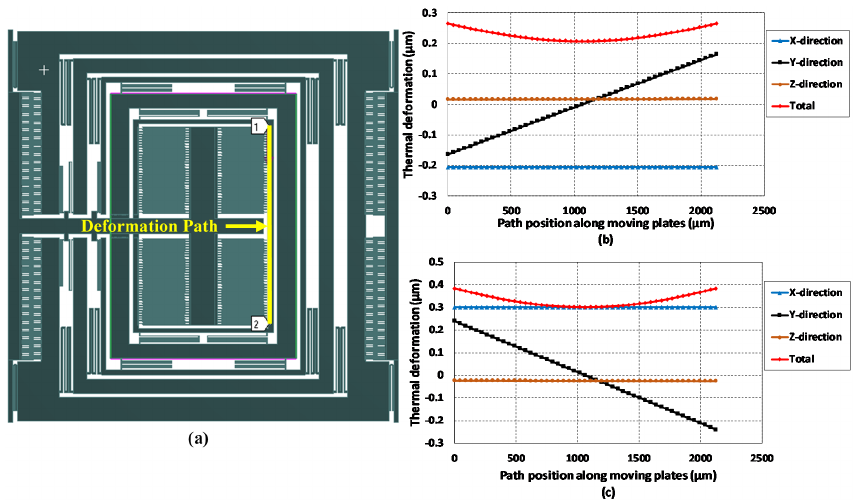
Figure 17. ( a ) Thermal deformation analysis path along with the sense mass m 3 b ( b ) thermal deformation at − 40 ◦ C. ( c ) thermal deformation at 100 ◦ C.